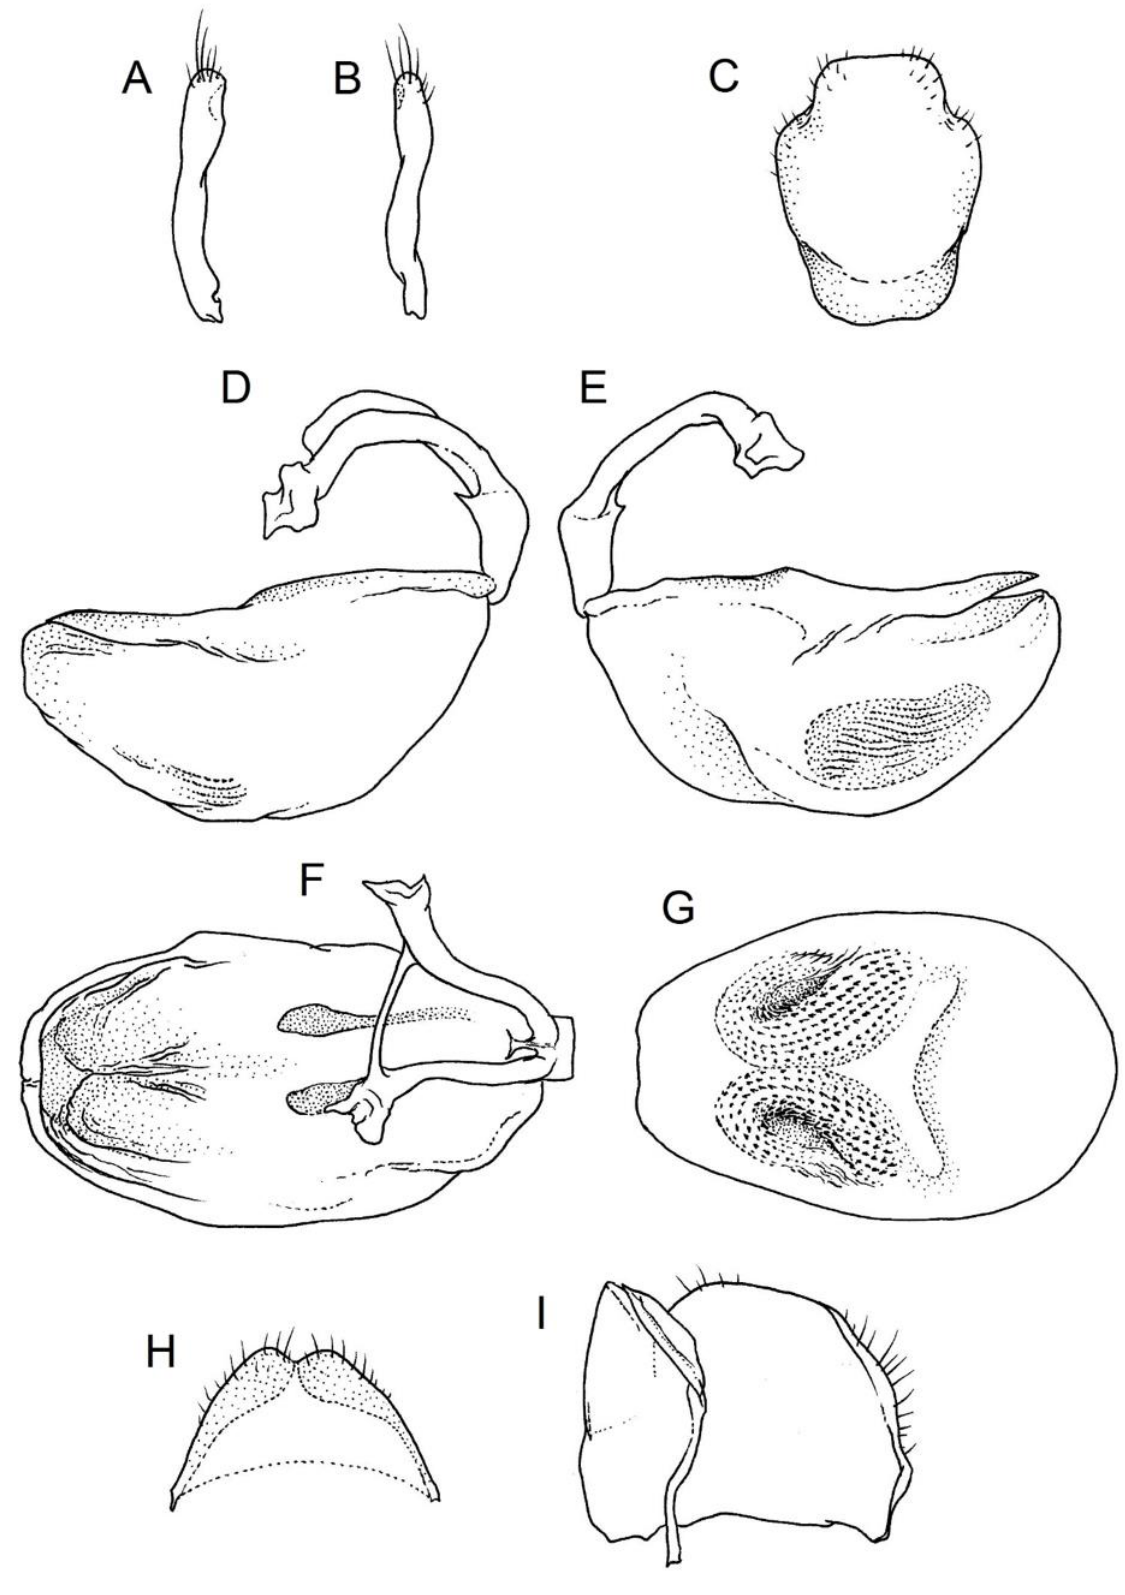
Figure 34. Phonoctonus caesar Haglund, 1895: ( A ) left paramere; ( B ) right paramere; ( C ) pygophore, ventral view; ( D ) aedeagus, right lateral view; ( E ) aedeagus, left lateral view; ( F ) aedeagus, dorsal view; ( G ) aedeagus, ventral view; ( H ) styloids, outer view; and ( I ) gonocoxite of abdominal segment VIII.